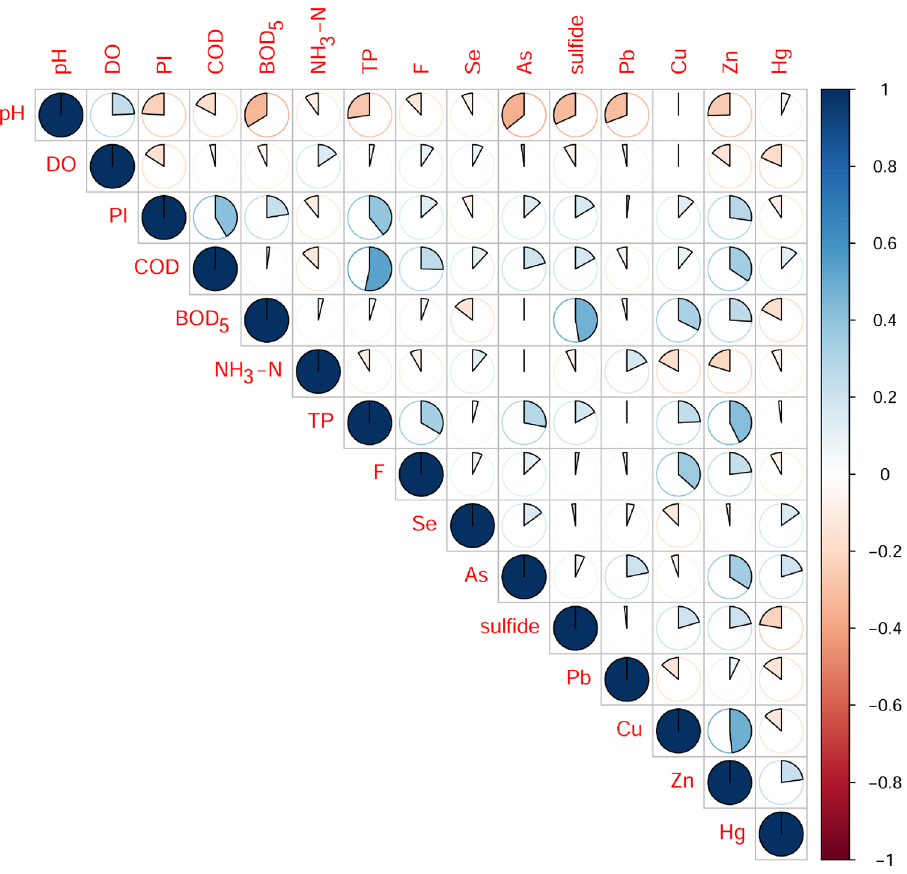
Figure 6. Correlation among water quality parameters during the period 2015 ~